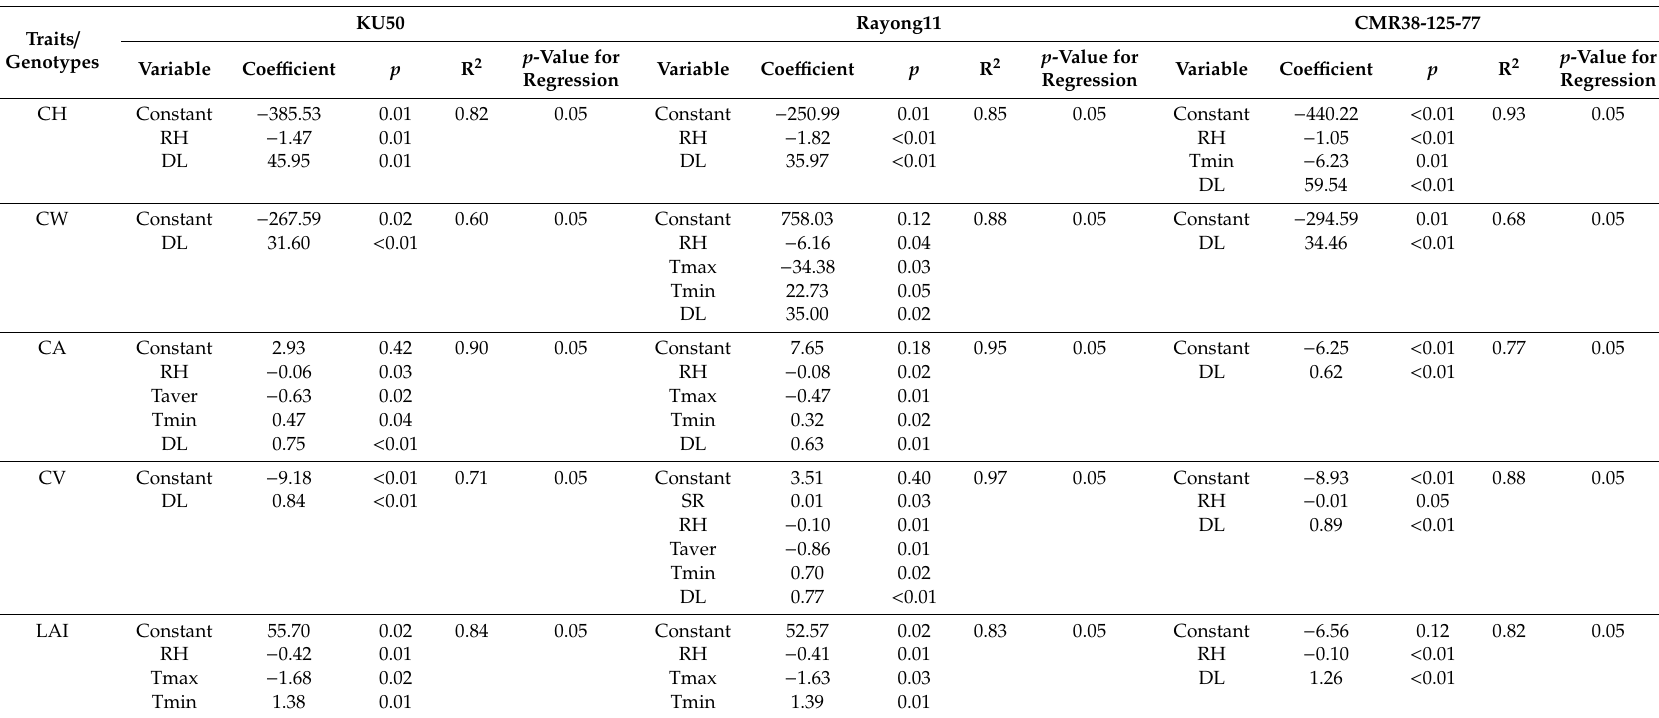
Table 4. Stepwise regression analysis for canopy traits and climatic factors for three cassava genotypes planted in November